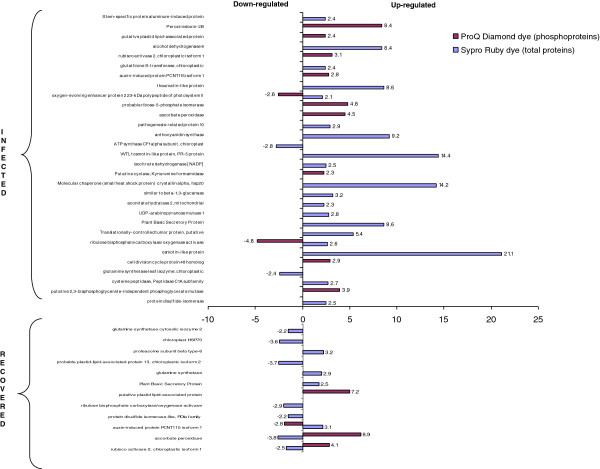
Expression levels of proteins in the “response to stimulus” category in infected and recovered plants compared to healthy plants. Singular Enrichment Analysis of GO categories distribution showed that the specific category “response to stimulus” (GO:0050896) was over-represented in both infected and recovered plants. The majority (71%) of the proteins belonging to this biological process was up-regulated in the infected plants, while, in contrast, 50% of the proteins was down-regulated in recovered plants compared to healthy plants. For each specific protein the fold change in expression value is reported compared to healthy plants (reference value = 1).